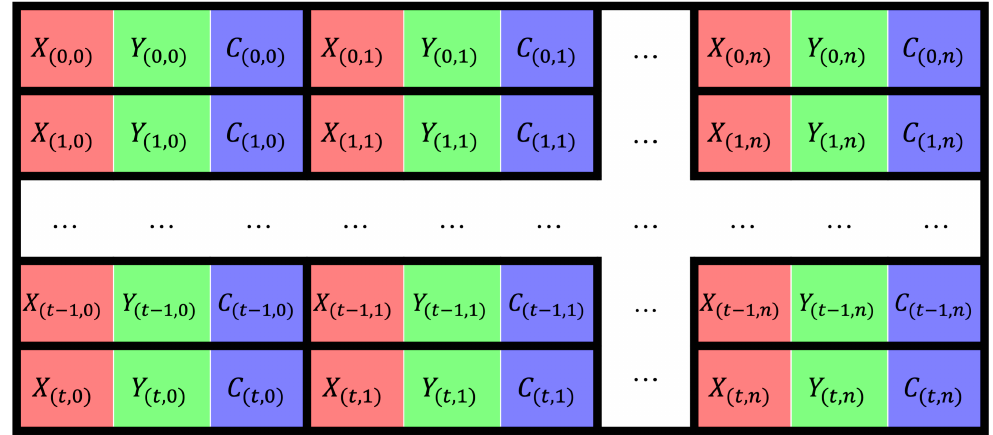
Figure 5. Construction of STmap images generated by the proposed method. One pixel in the STmap image corresponds to one extracted keypoint. The horizontal axis constituting the image is a series of keypoints, and one row consists of 135 keypoints extracted from the body. The order is from left to right, that is, left hand (21 keypoints), right hand (21 keypoints), face (70 keypoints) and body (25 keypoints). The vertical axis means time, and moving to the next row is the same as moving to the next frame of the video. Figure 6 shows the result of converting the word ‘burn’ in Korean sign language into an STmap image.